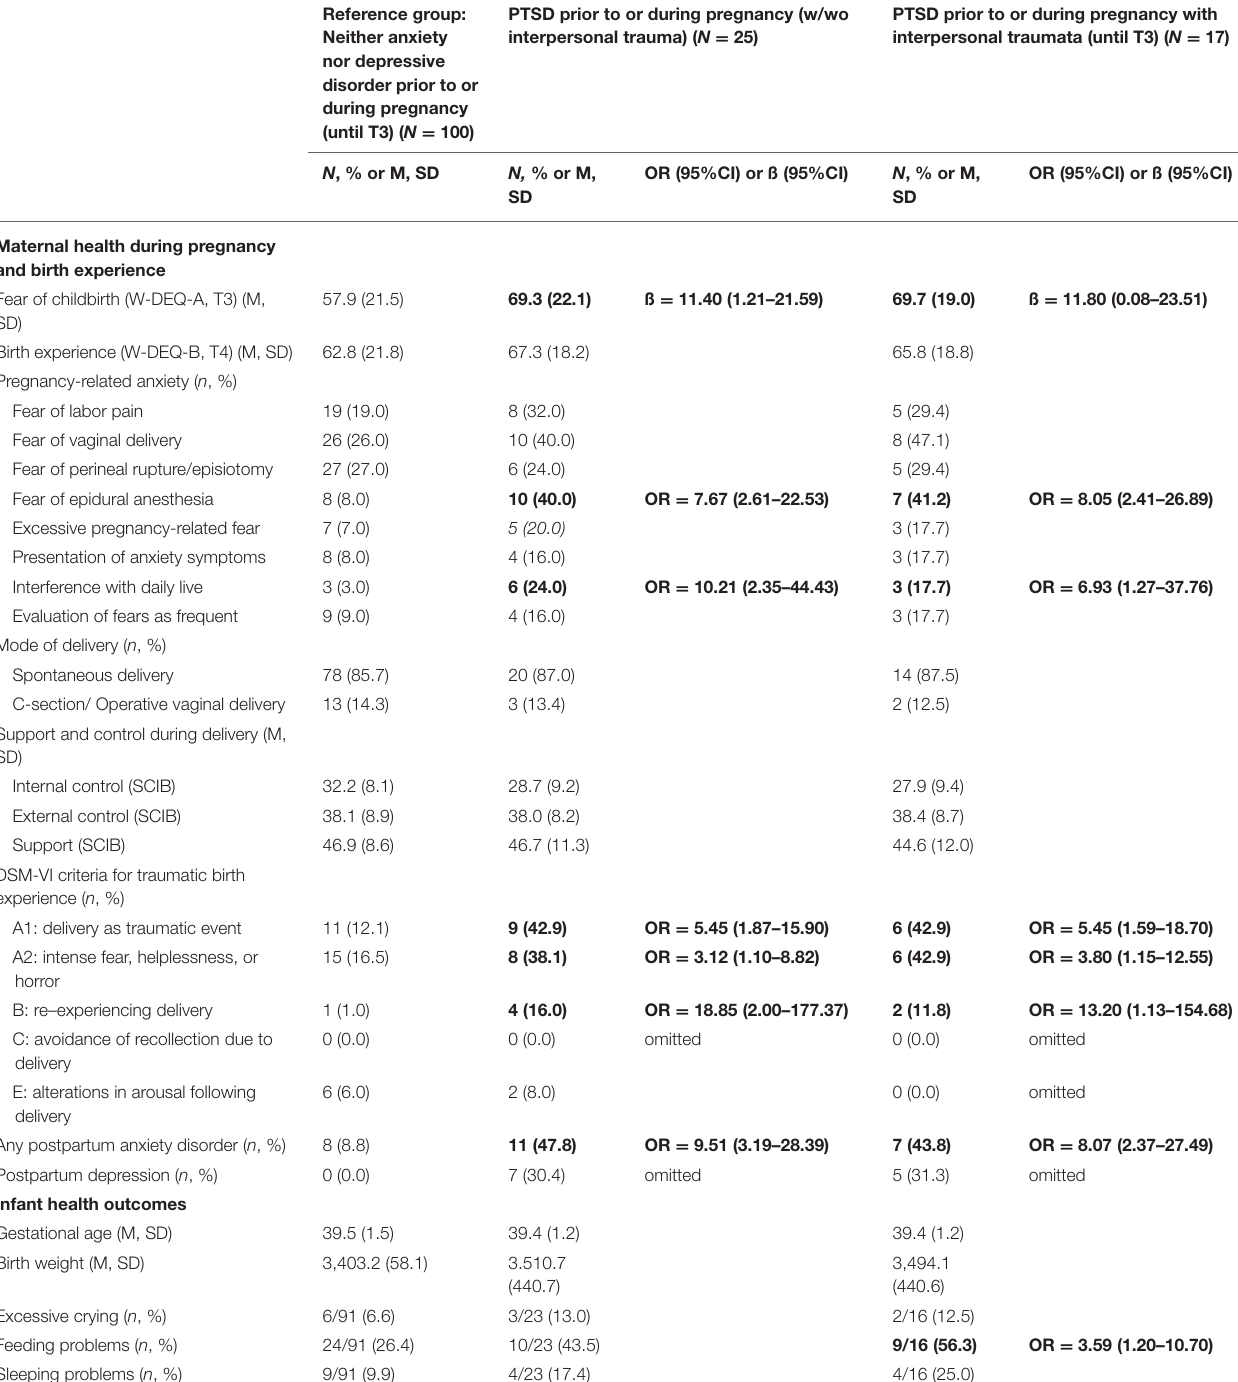
TABLE 2 | Maternal and infant outcomes in women with PTSD prior to or during pregnancy (with interpersonal trauma) compared to women with neither anxiety nor depressive disorder until T3.